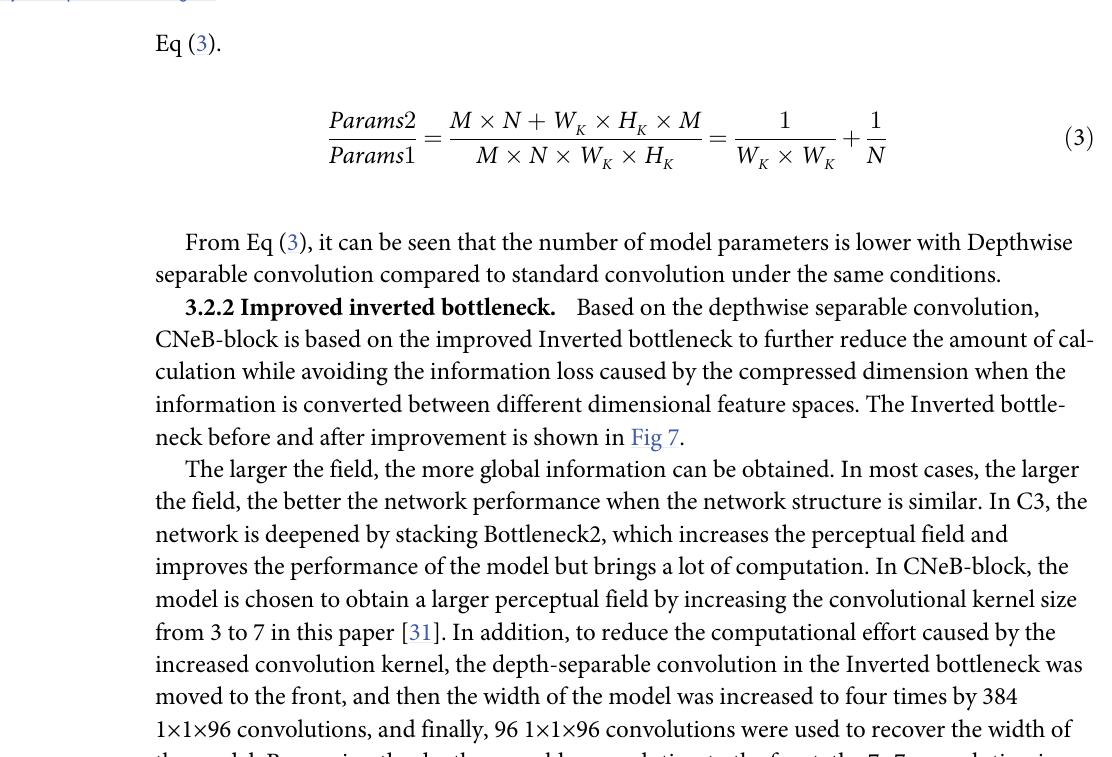
Fig 6. Comparison of standard convolution with depthwise separable convolution. (a) Standard convolution (b) Depthwise separable convolution.